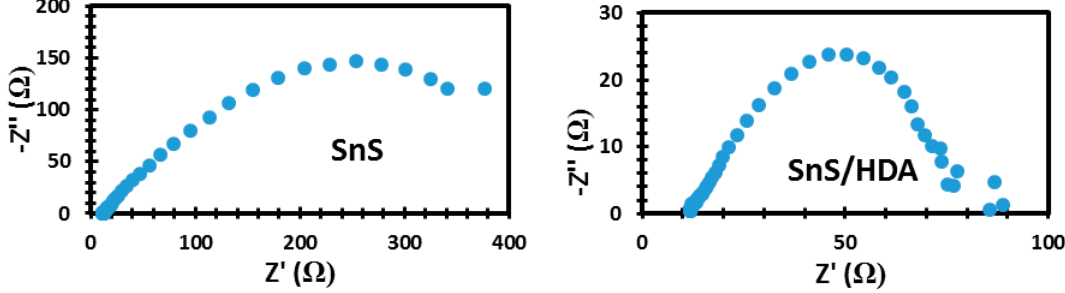
Figure 4. Electrochemical impedance spectroscopy (EIS) spectra of SnS/HDA and SnS nanoparticles.